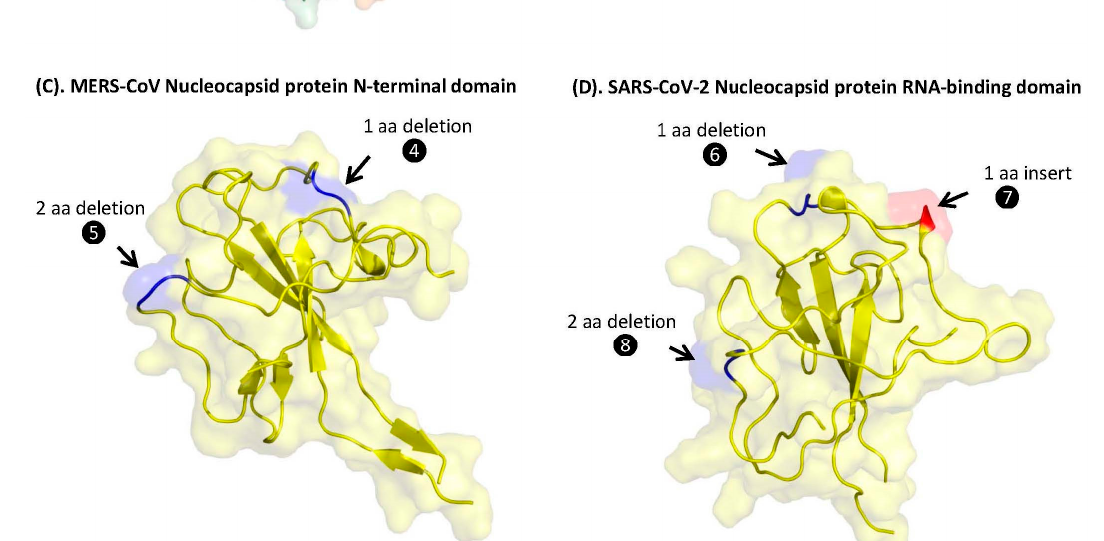
Figure 6. Mapping the surface locations of eight of the identified CSIs in the spike and nucleocapsid proteins. ( A ) Cryo-EM-based structure of the post-fusion form of the SARS-CoV spike protein (PDB ID: 6m3w) showing the structural location of CSIs ❶ and ❷ . The regions where these CSIs are found are circled. Of these two CSIs, ( ❶ ) is present within the HR2 motif, whereas CSI ❷ is found within the HR1 motif in the S2 subunit. ( B ) The structural location of the 4-aa CSI ( ❿ ), which is commonly shared by the Merbecovirus, Nobecovirus , and Sarbecovirus subgenera, using a superimposed structure of the spike protein from SARS-CoV-2 (shown in green) and the PEDV virus (shown in cyan color). ( C ) Crystal structure of the N-terminal domain of the N-protein (PDB ID: 6LNN) from MERS-CoV in which the structural locations of two CSIs ( ❹ and ❺ ) are highlighted. ( D ) Structure of the RNA-binding domain (RBD) of the N-protein (PDB ID: 7R98) from SARS-CoV-2 depicting the structural locations of three CSIs ( ❻ , ❼ , and ❽ ) in RBD.